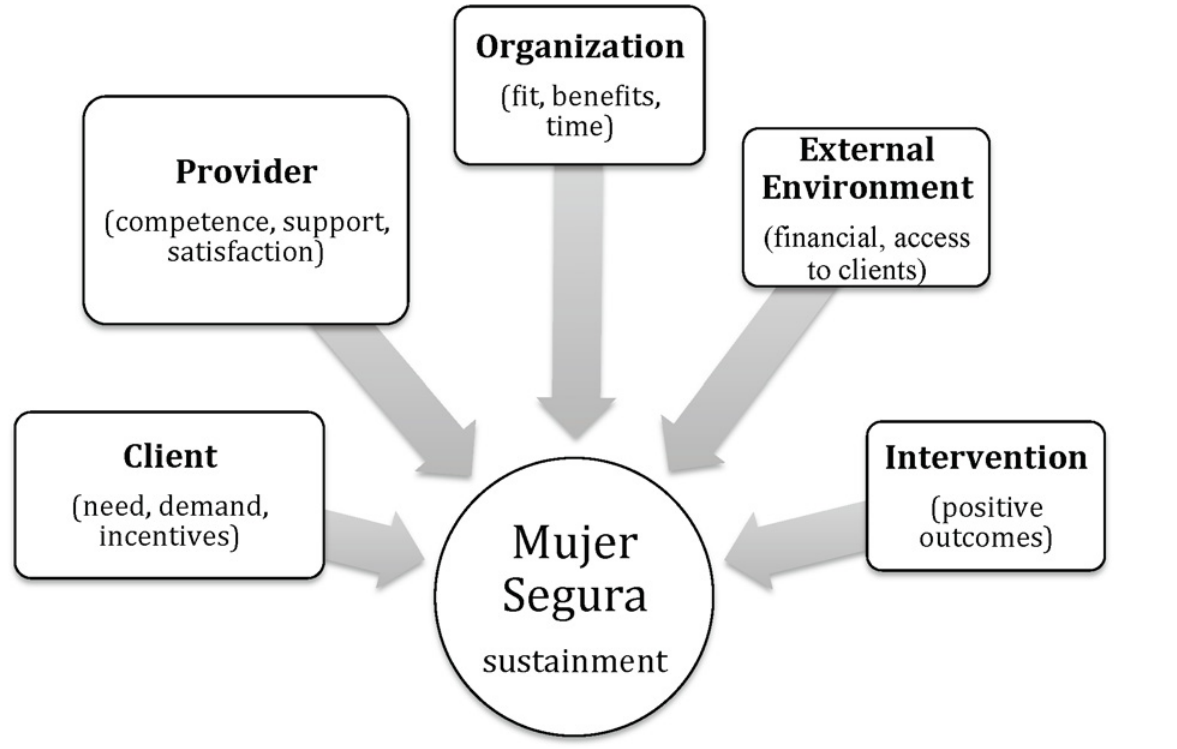
Fig 1. Requirements for sustainment of the Mujer Segura